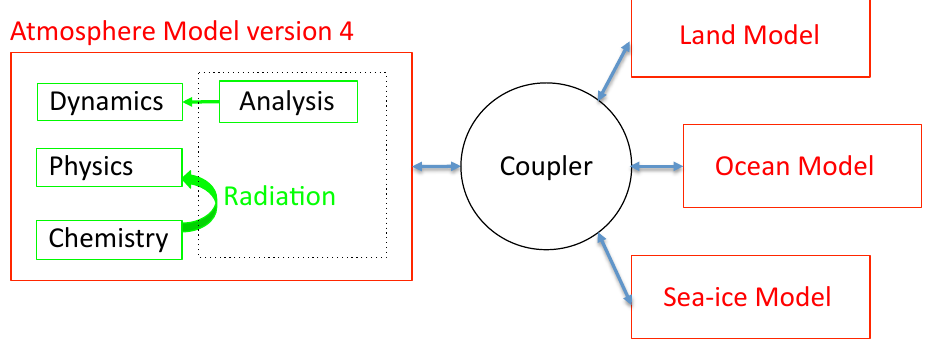
Fig. 1. Schematic representation of the Community Earth System Model. The dotted box indicates the features associated with the use of specified dynamics (use of meteorological analyses and lack of feedback through